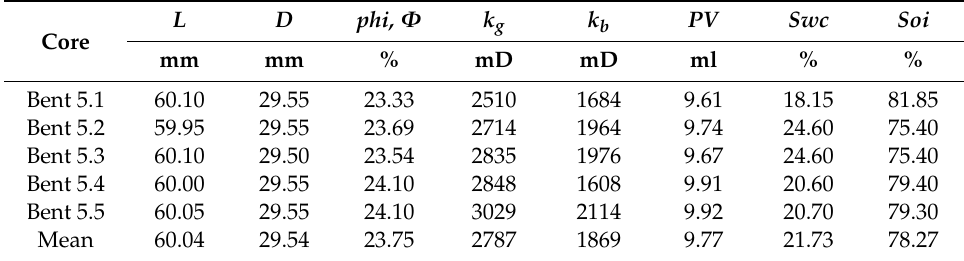
Table 3. Characteristics of the core plugs used in this work.